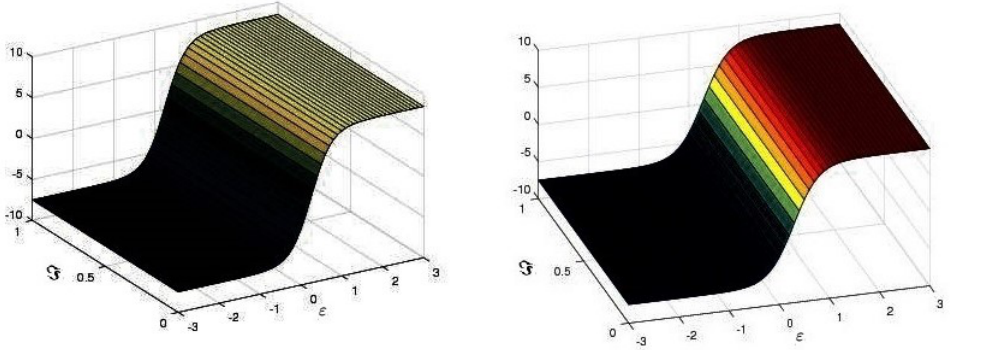
Figure 1. The actual and YDM solution of U ( ε , (cid:61) ) at ℘ = 1 of Example 1.